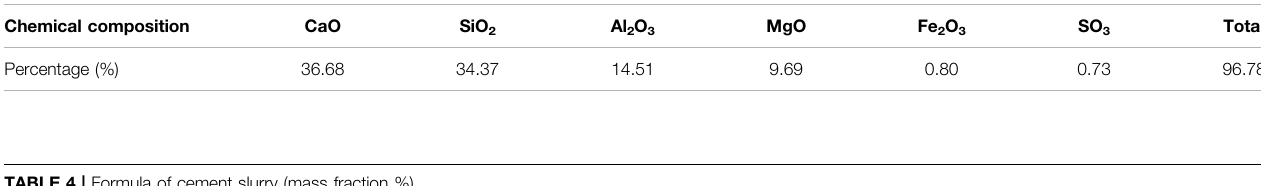
TABLE 3 | Chemical composition of high temperature stabilizer.